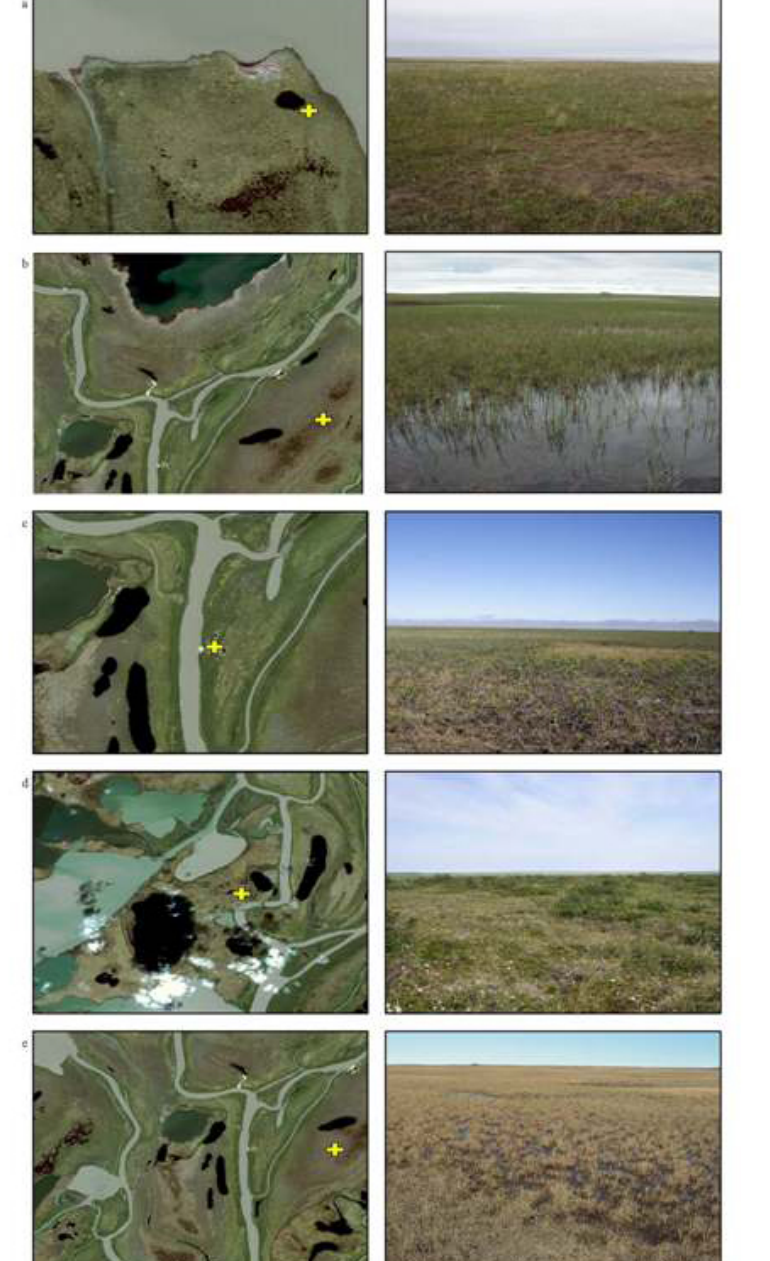
Fig. 7. Clips of IKONOS imagery representing the different habitat types, with corresponding photographs of the representative habitat. Yellow crosses indicate the specific location represented by the photograph. (a) Non-shrubby lowland habitat; (b) saturated habitat; (c) dense shrub lowland habitat; (d) dry upland tundra habitat; (e) wet-sedge low-centered polygon